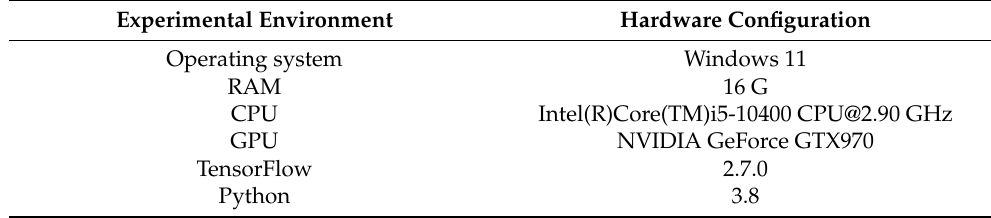
Table 3. Experimental environment